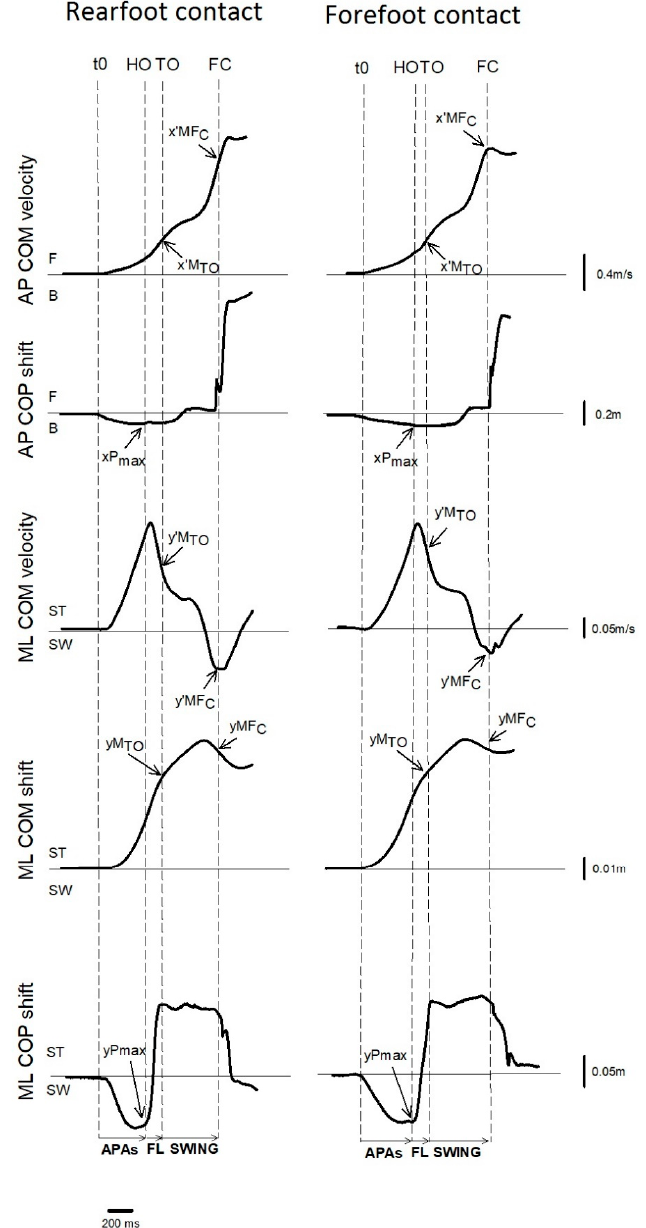
Figure 2. Typical biomechanical traces and representation of the main experimental variables (horizontal plane). Traces are from one representative subject initiating gait in the ( left ) rearfoot strike condition and the ( right ) forefoot strike (FFS) condition. Anteroposterior (AP) direction. x’M TO , x’M FC : centre of mass (COM) velocity at toe-o ff and foot contact; x Pmax: peak of centre of pressure (COP) displacement during anticipatory postural adjustments (APAs); F: forward; B: backward. Mediolateral (ML) direction. y’M TO , y’M FC : COM velocity at toe-o ff and foot contact; yM TO , yM FC : COM displacement at toe-o ff and foot contact; yPmax: peak of COP displacement during APAs; ST: stance limb; SW: swing limb. Vertical dashed lines: t 0 onset variation of biomechanical traces; HO: swing heel-o ff ; TO: swing toe-o ff ; FC: swing foot contact. Horizontal arrows. APAs: anticipatory postural adjustments; FL: swing foot lift; SWING: swing phase of gait